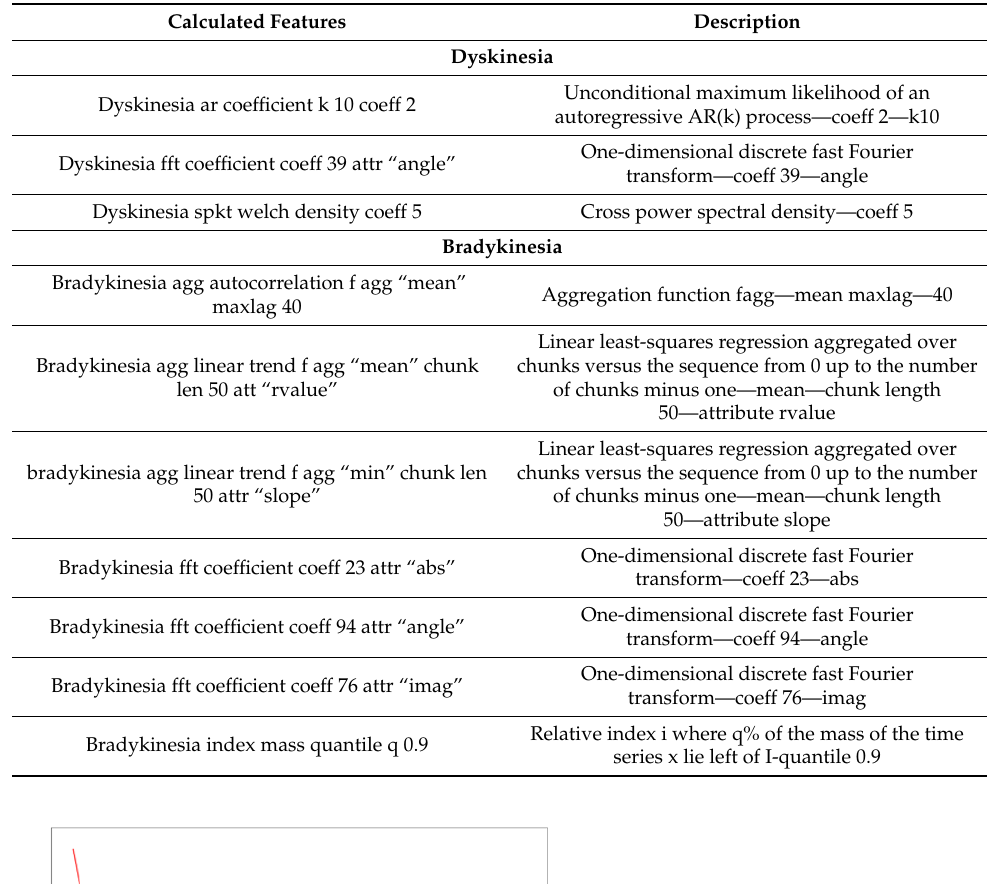
Table A1. Features included in the random forest analysis based on preliminary experiments.